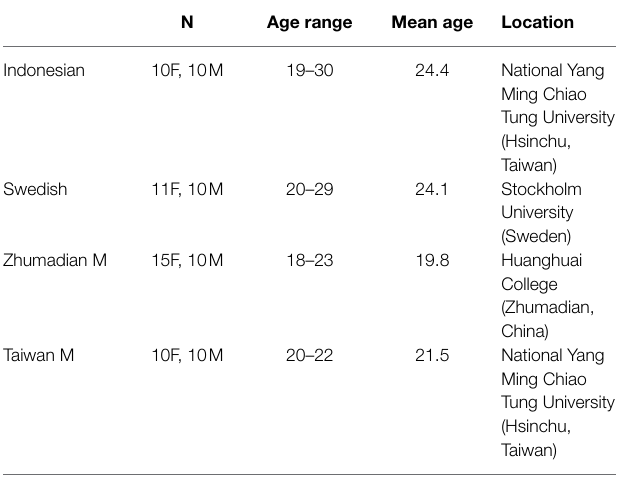
TABLE 4 | Participants in four language